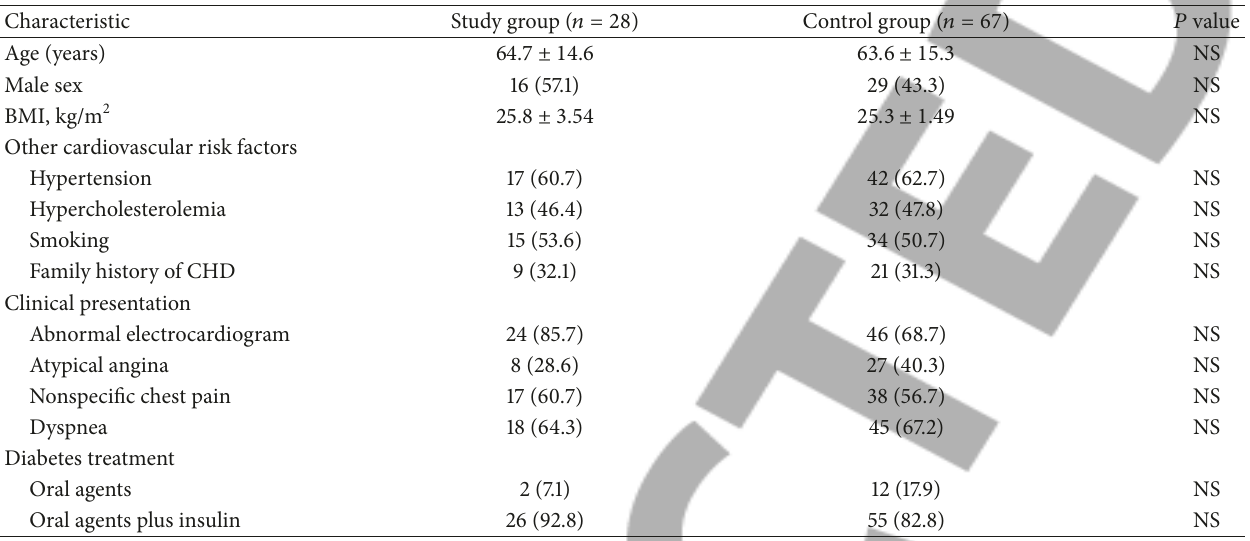
Table 1: Baseline characteristics.